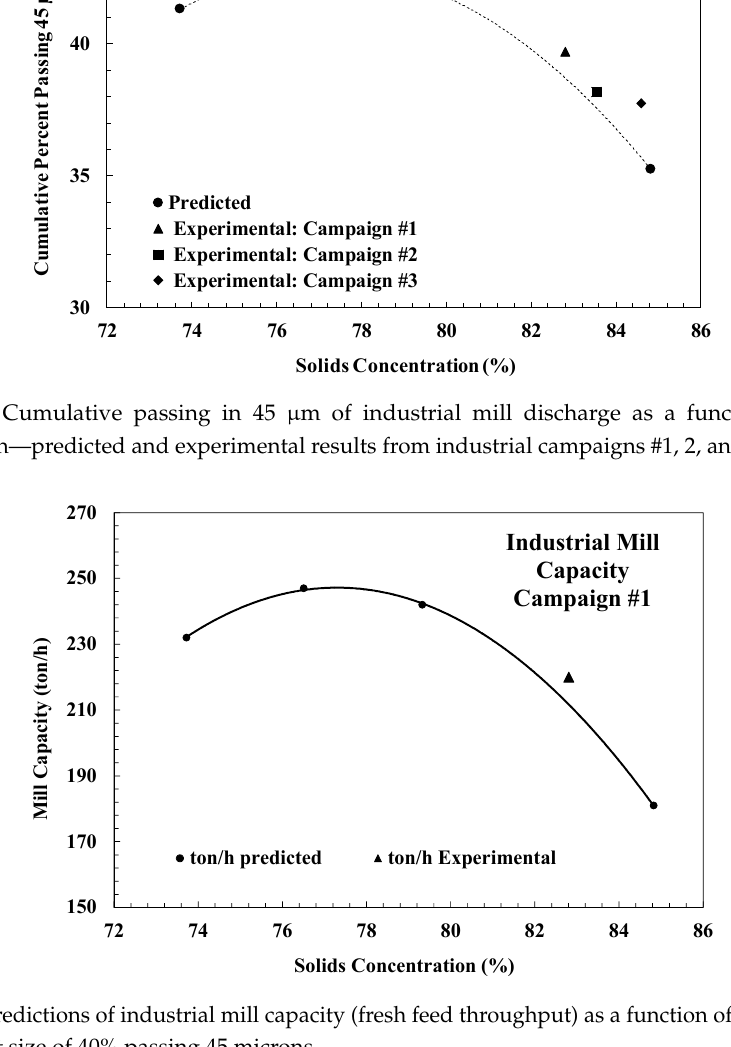
Figure 18. Predictions of industrial mill capacity (fresh feed throughput) as a function of percent solids for a product size of 40% passing 45 microns.